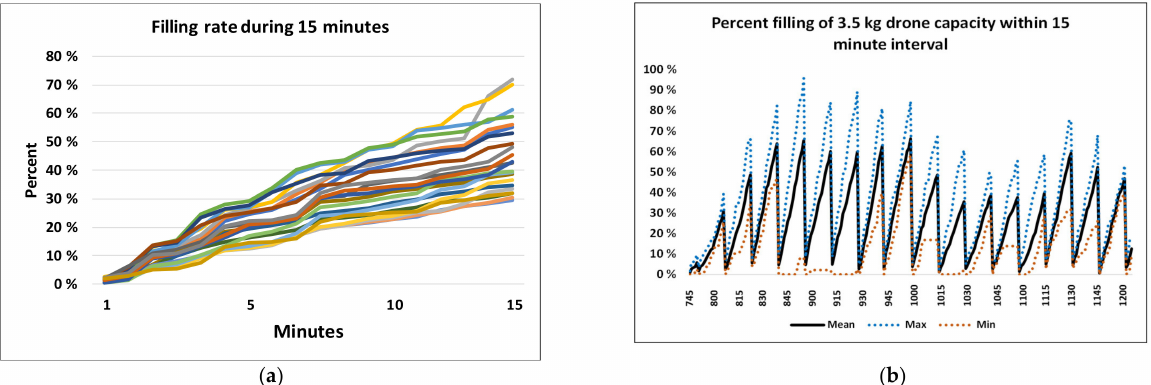
Figure 10. ( a ) Illustrations of the arrival and filling rates over 15 min intervals. Accumulated arrival of sample rates over 15 min intervals; ( b ) Variation in the percentage utilization of a 3.5 kg drone